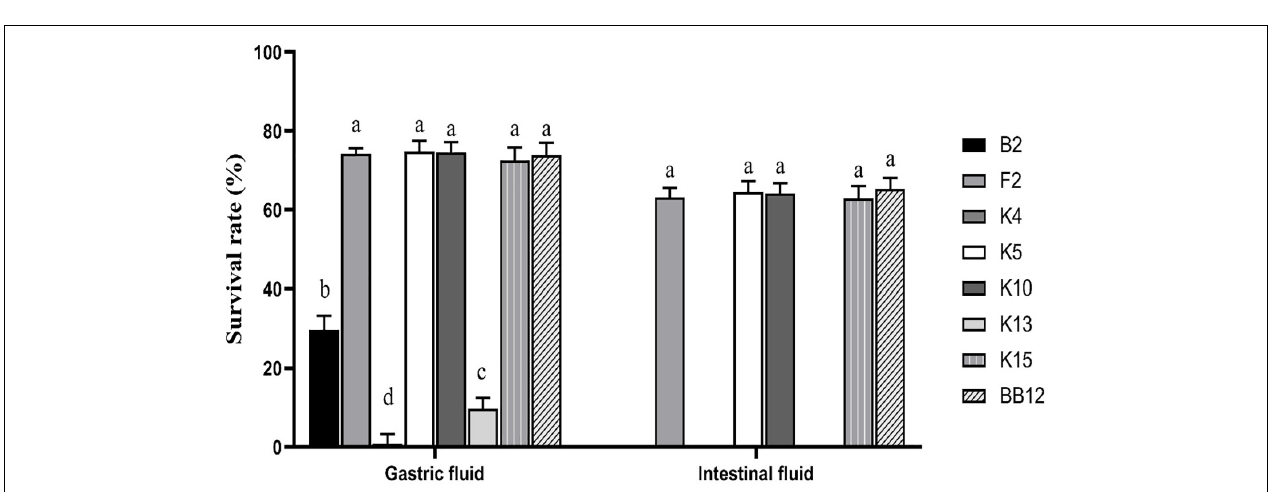
FIGURE 6 | Survival rate of B. longum subsp. longum strains in the simulation of gastrointestinal digestion. P < 0.05 was considered to demonstrate statistically significant differences and recorded with different letters.